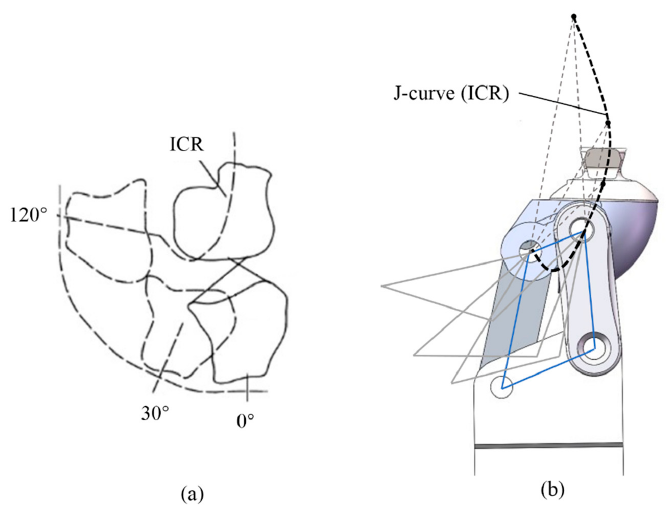
Figure 2. Bio-inspired design of the knee joint. ( a ) The biological structure of the human knee; ( b ) Four-bar mechanism.